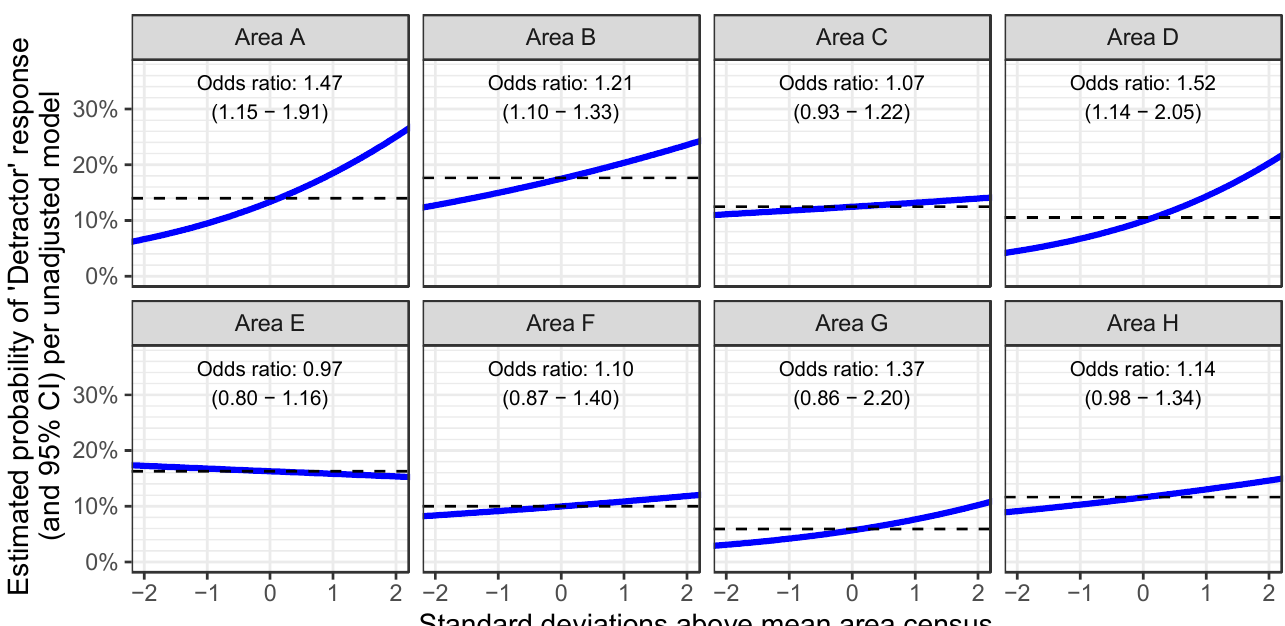
Figure 2. Estimated probability of detractor survey response as predicted by care area census. CI , confidence